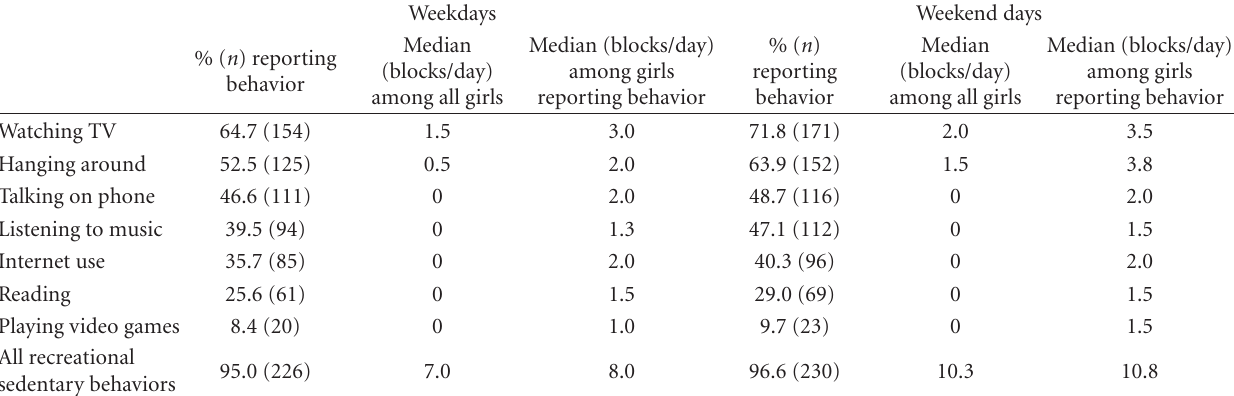
Table 1: Percentage of girls participating in recreational sedentary behaviors and time spent engaging in behavior on weekdays and weekend